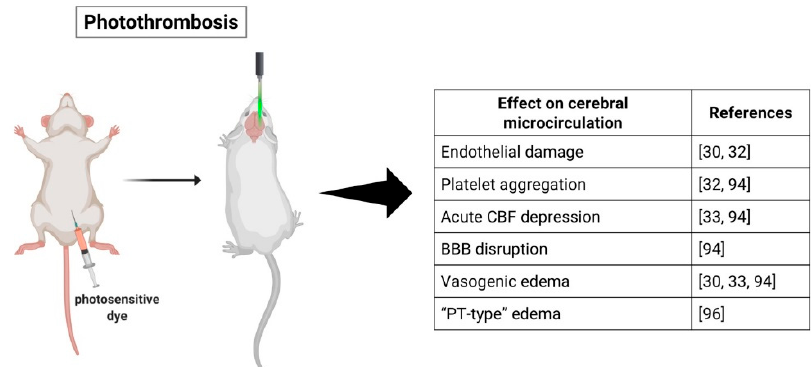
Figure 2. Schematic representation of the photothrombotic stroke (PTS) model and its effects on the cerebral microcirculation. Figure created with Biorender (https://biorender.com). Cerebral blood flow, CBF; blood–brain barrier, BBB.